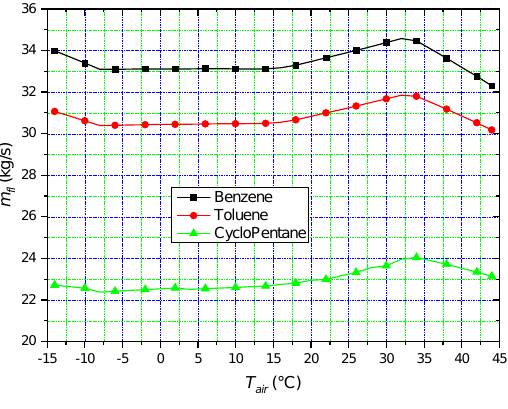
Figure 9. Organic fluid mass flow rate varying ambient